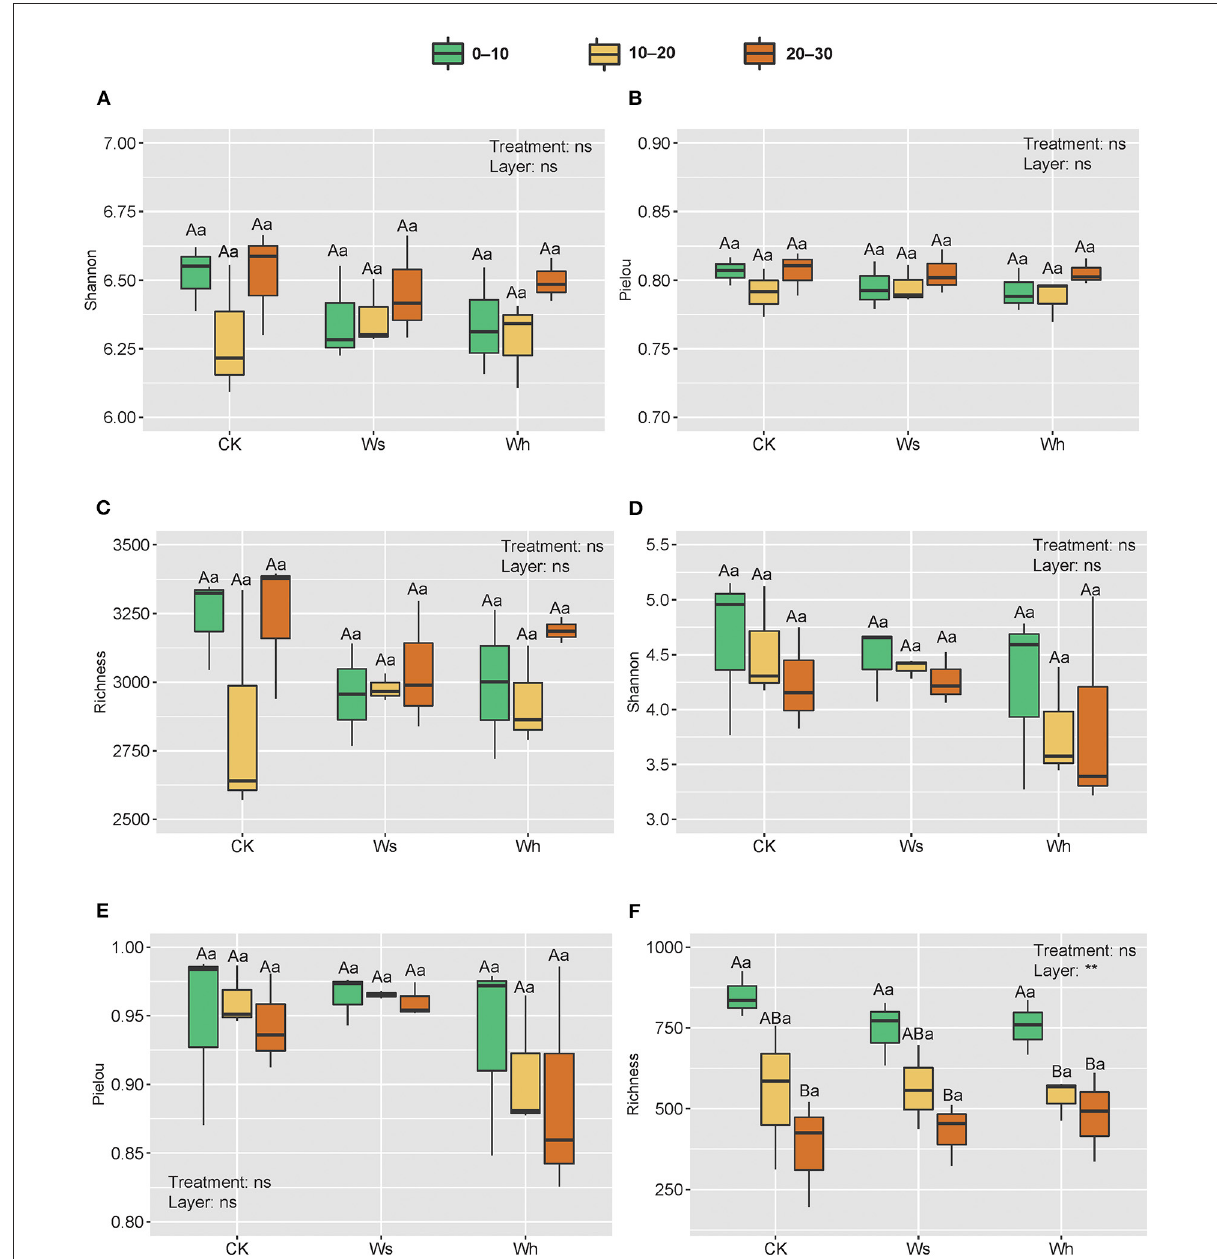
FIGURE2 Richness and alpha diversity index of soil bacterial (A–C) and fungal (D–F) communities. Ws, slight warming; Wh, high warming. ** and ns indicate the significant levels for treatments and soil depths (nested within treatments) at 0.01 and non-significant, respectively. Boxplots not sharing a common capital letter are significantly different ( p < 0.05) among soil layers while different small letters represent significantly different ( p < 0.05) among